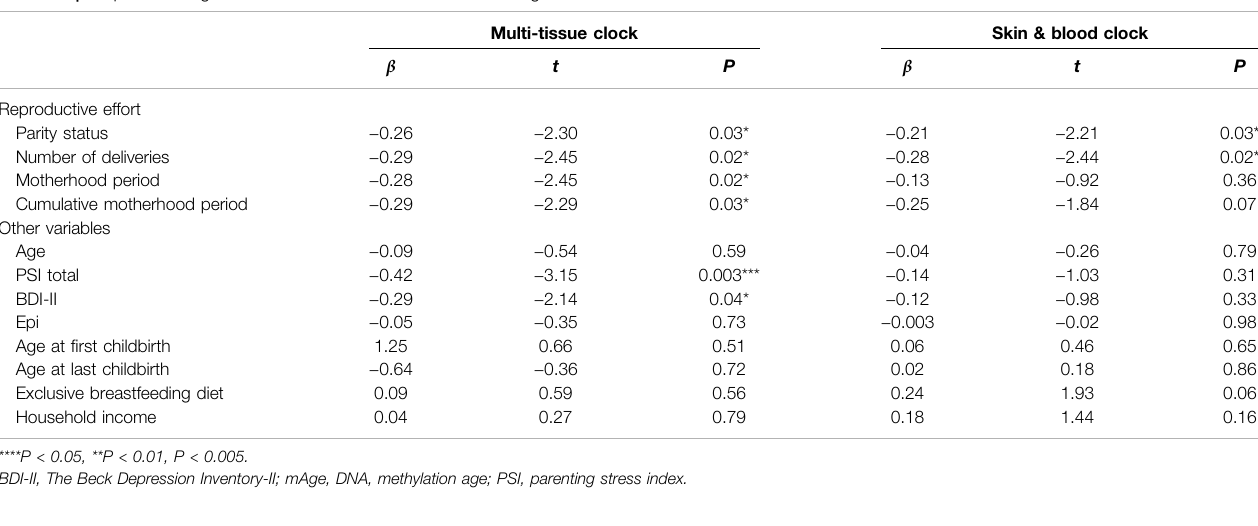
( Figure 1 ). PSI total ( β = − 0.42, t = − 3.15, P = 0.003) and BDI-II ( β = − 0.29, t = − 2.14, P = 0.04) were signi fi cantly associated with mAge acceleration calculated by the multi- tissue clock. No other demographic characteristics were associated with mAge acceleration for both calculations ( Table 2 ). The correlation coef fi cients matrix between all the covariate combinations used in the analysis are shown in Supplementary Figure S4 .